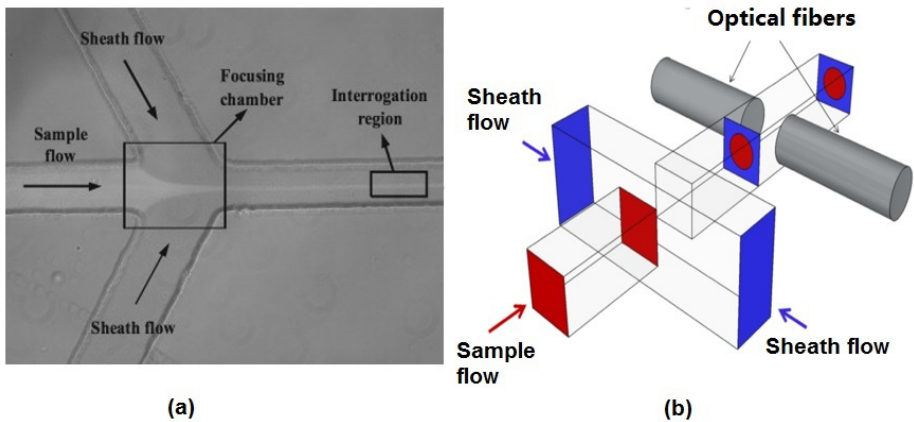
Figure 2. Reported hydrodynamic focusing methods in a microflow cytometer. ( a ) A typical structure of 2D hydrodynamic focusing. Reproduced from [24]. ( b ) A straight forward 3D hydrodynamic focusing structure. Reprinted from [31] with kind permission from OSA